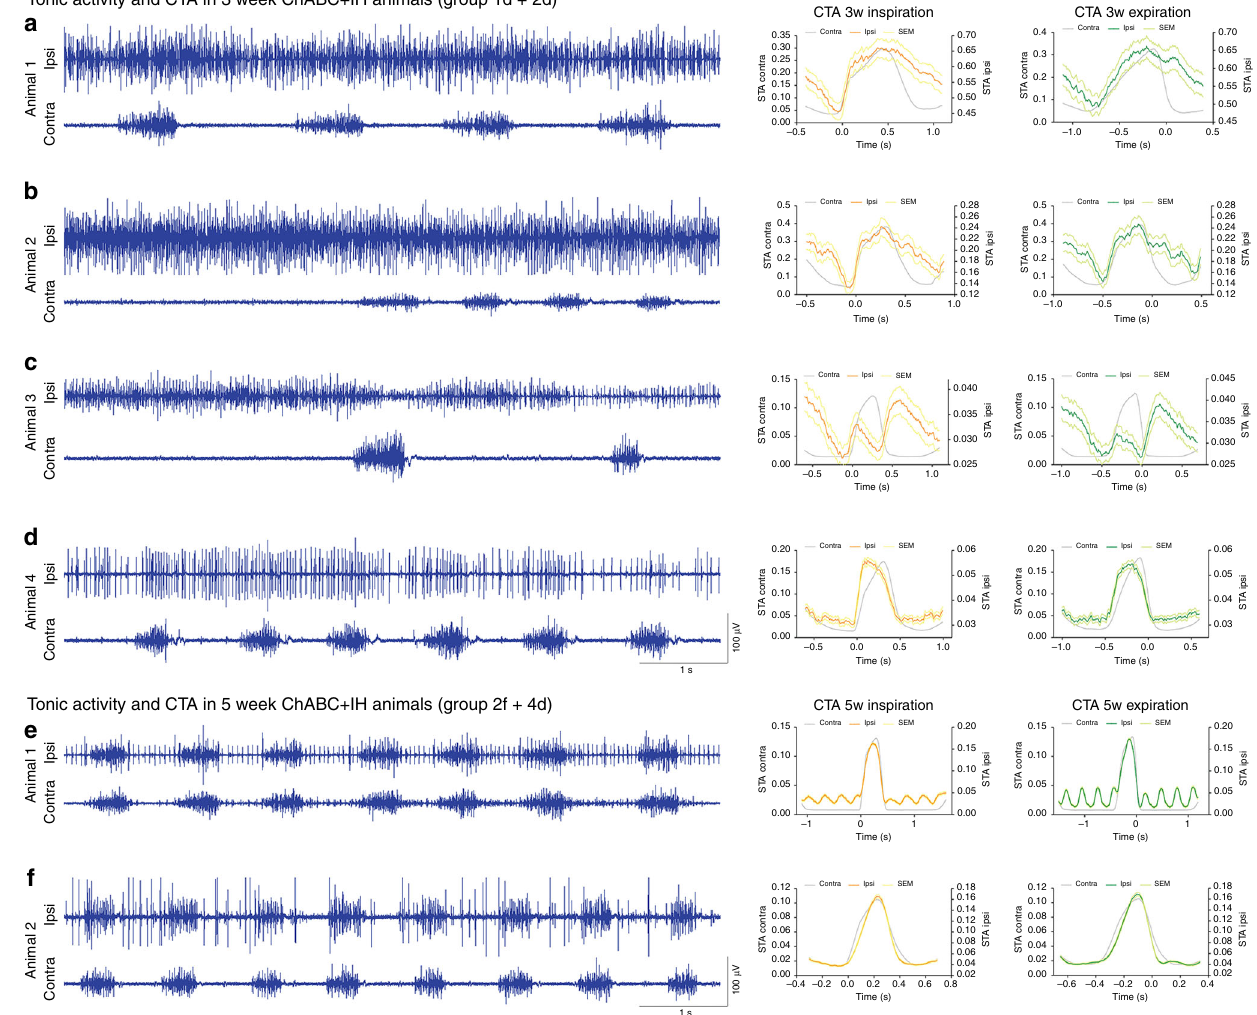
Fig. 5 Representative diaEMG traces of ChABC + IH (blue) animals that displayed tonic fi ring of the ipsilateral hemidiaphragm ( n = 6). a – d Tonic activity exhibited in animals with 3 weeks of conditioning. CTAs generated with triggers at the onset of inspiration and expiration. Panels ( b , c ) demonstrate that the onset of tonic ipsilateral hemidiaphragm fi ring can reduce the fi ring frequency of the contralateral hemidiaphragm. e , f Tonic activity exhibited in animals with 5 weeks of conditioning. CTAs reveal inhibition of tonic activity before the onset of inspiration and expiration. CTA on panel ( e ) shows the effect on cardiovascular activity on the trace. Panels recorded in the same animal. For all panels: animals were treated with ChABC + IH (blue EMG traces); CTAs shown of ipsilateral (coloured) and contralateral (grey) activity for mean inspiration (orange) and expiration (green) where ±SEM is shown for both inspiration (yellow) and expiration (light